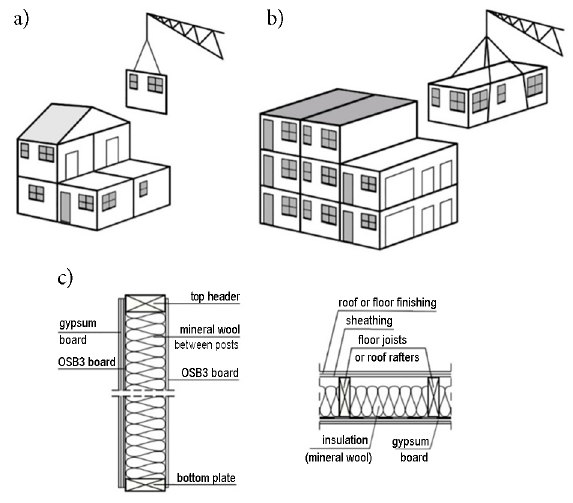
Figure 1. Assembly of structural elements at the site: a – large panels, walls and floor diaphragms; b – modular 3D elements; c – cross-section of structural wall panel and floor diaphragm, elements in the wood-framed technology with